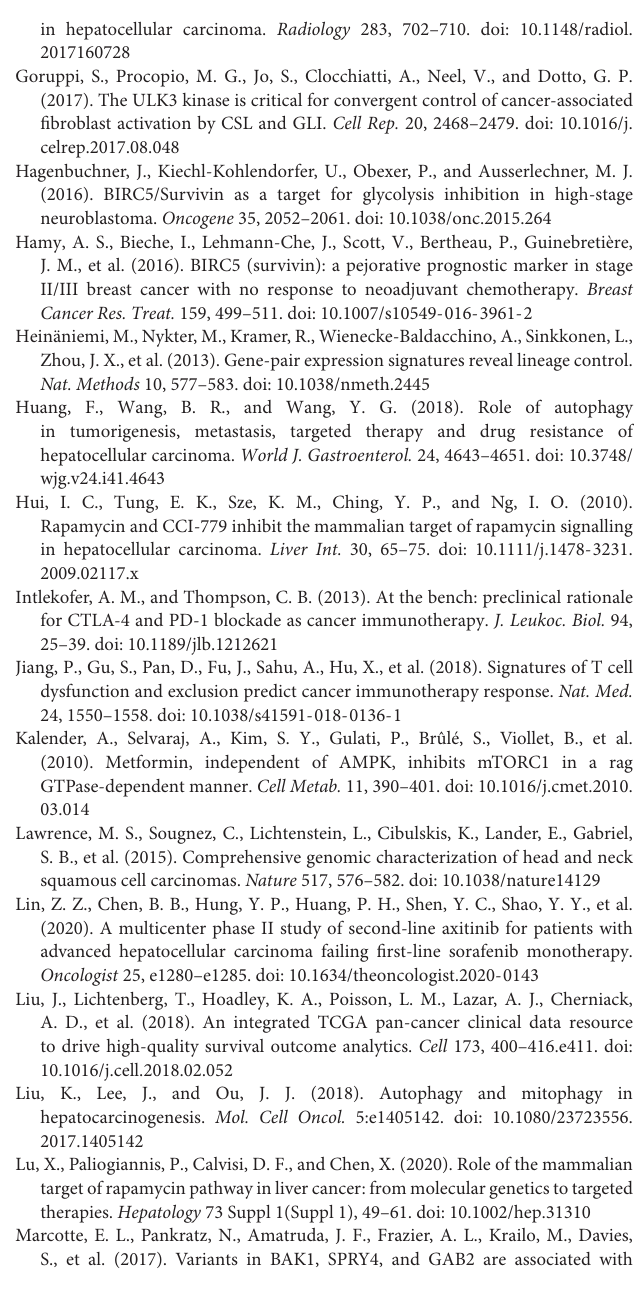
Supplementary Figure 2 | Subgroup analysis in the training set and ICGC set. (A,B) The KM curve represents the OS of high- and low-risk groups in different subgroups of the training set. (C) The KM curve represents the OS of high- and low-risk groups in different subgroups of the ICGC set. Supplementary Figure 3 | Subgroup analysis in the test set and TCGA set. (A,B) The KM curve represents the OS of high- and low-risk groups in different subgroups of the test set. (C,D) The KM curve represents the OS of high- and low-risk groups in different subgroups of the TCGA set. Supplementary Figure 4 | Clinical relevance analysis of risk score. (A–D) The relationship of stage group with risk score in the training set, test set, TCGA set, and ICGC set, respectively. (E–G) The relationship of grade group with risk score in the training set, test set, and TCGA set,